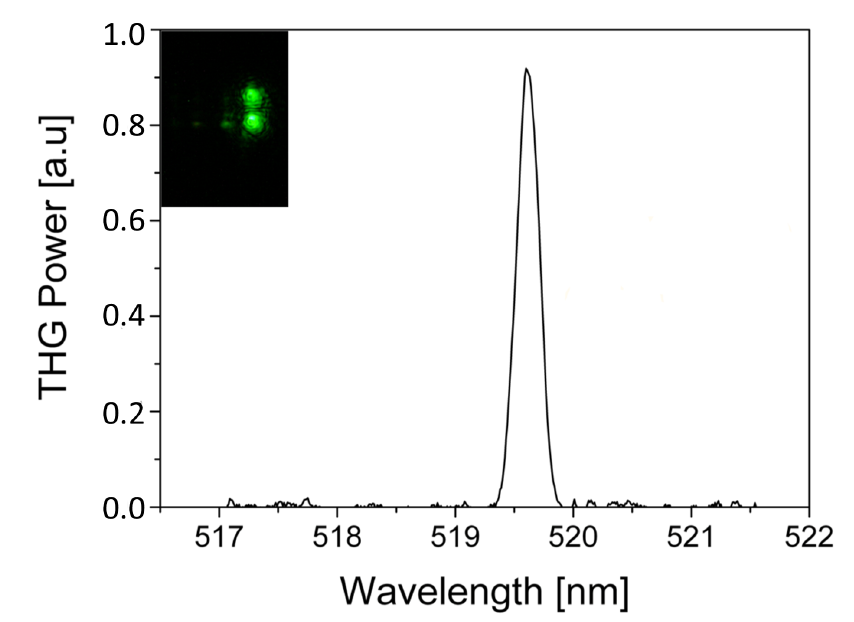
Figure 3. Emission spectrum indicating third-harmonic generation at 519.6 nm when pumping at 1556.9 nm, whereas the inset picture was taken during the spectral measurements. Reproduced with modifications from Ref.